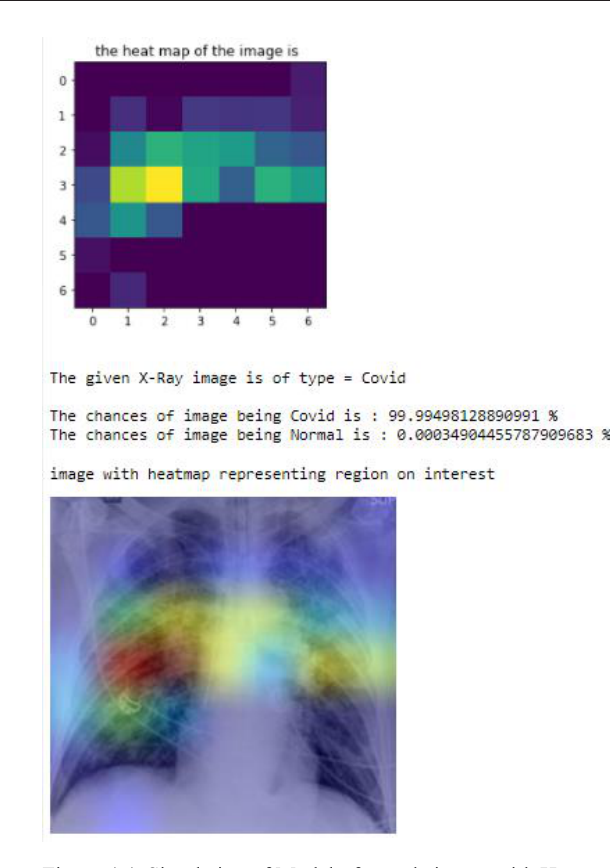
Figure 4.4: Simulation of Model of sample image with Heat- Map The overall simulation results in an accuracy of 97.5 percentage (Figure 4.5), as opposed to the traditional accuracy of about 84 with global thresholding for image classification.